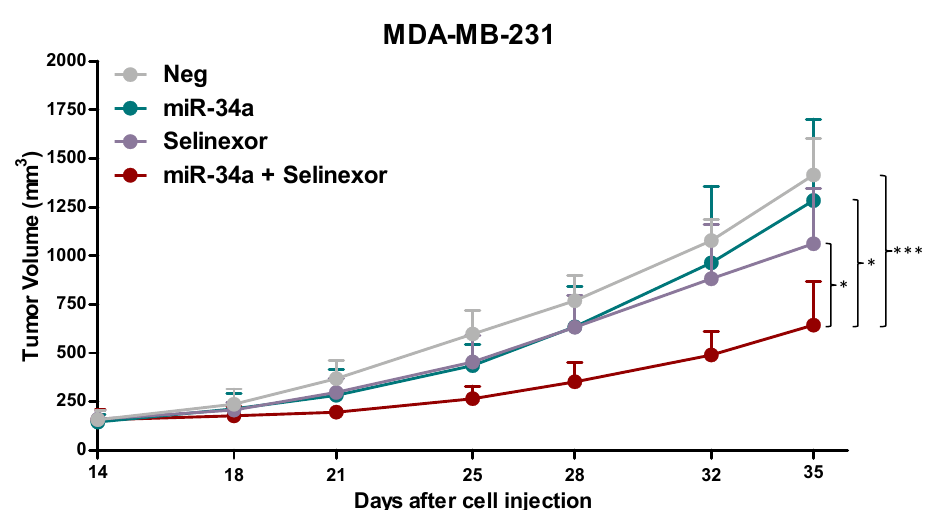
Figure 6. miR-34a ectopic expression improves the anti-tumor activity of oral selinexor in orthotopic TNBC xenografts. Tumor growth curves of Neg- or miR-34a-MDA-MB-231 cells orthotopically injected into SCID mice. Mice (6 mice/group) were randomly grouped to receive vehicle (ctr) or selinexor (10 mg/kg, q3-4d × 8). Each point indicates the mean tumor volume in the group ± SD. * p < 0.05, *** p < 0.005, Dunn’s post hoc test.